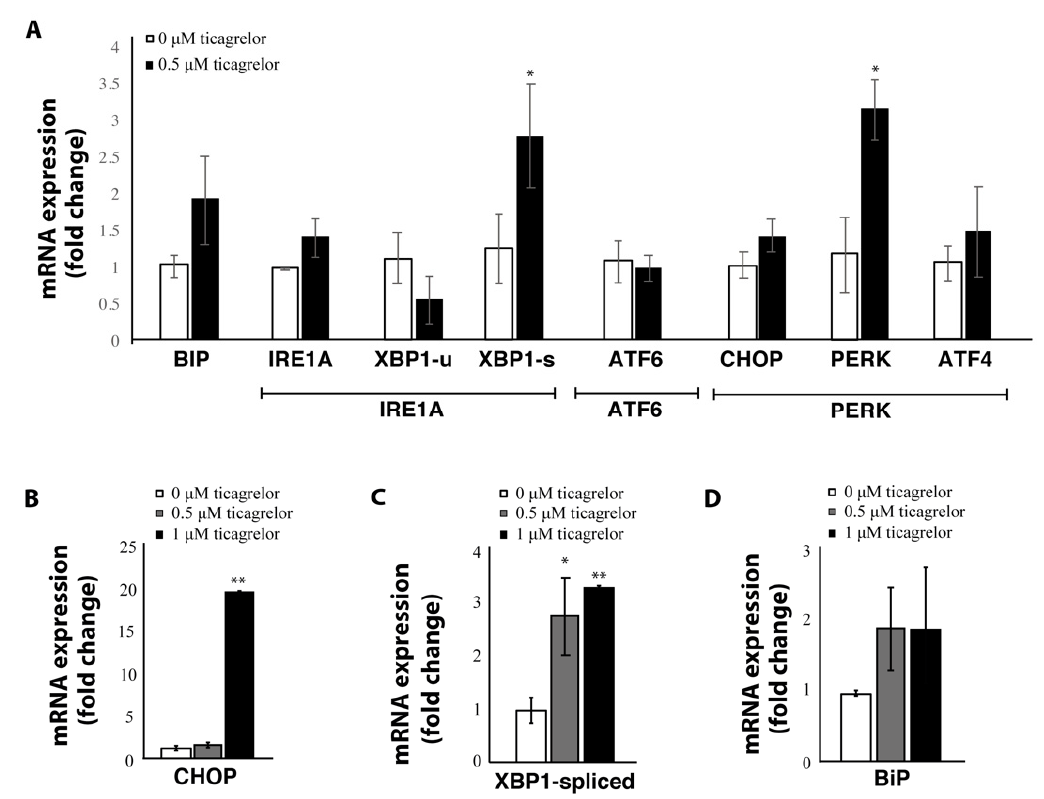
Figure 6. Expression of ER stress genes is increased after P2Y12 inhibition with ticagrelor. ( A ) mRNA expression of di ff erent ER stress genes covering the three arms of the unfolded protein response (inositol-requiring enzyme alpha (IRE1 α ), activating transcription factor 6 (ATF6) and protein kinase R-like endoplasmic reticulum kinase (PERK)) in THP1-di ff erentiated macrophages treated with, 0.5 µ M ticagrelor. ( B ) CHOP in THP1-di ff erentiated macrophages treated with 0 µ M, 0.5 µ M and 1 µ M ticagrelor. ( C ) mRNA expression of spliced XBP1 in THP1-di ff erentiated macrophages treated with 0 µ M, 0.5 µ M and 1 µ M. ( D ) mRNA expression of BIP in THP1-di ff erentiated macrophages treated with 0 µ M, 0.5 µ M and 1 µ M ticagrelor. * = p < 0.05; ** = p < 0.01.